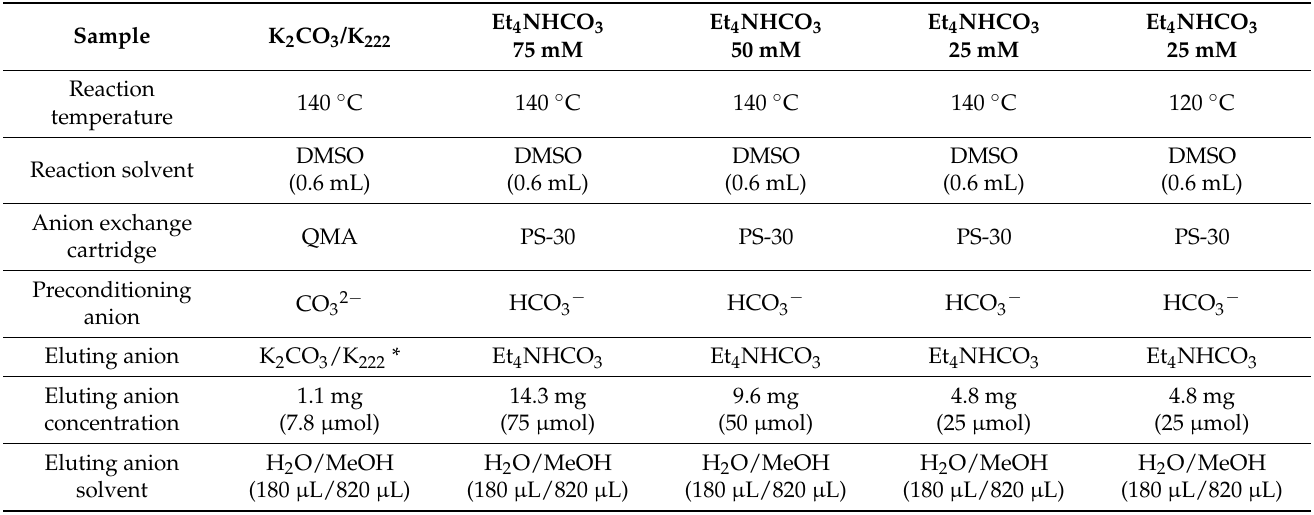
Table 4. Specified details for the first manual stability tests of FE-PE2I and OTsE-PE2I and the manual fluorination reaction of [ 18 F]FE-PE2I. * Two equivalents of K 222 used compared to K 2 CO 3 .